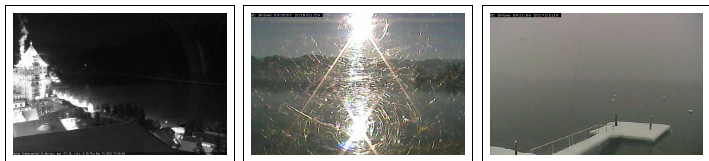
Figure 4. Example images that were discarded from the dataset due to bad illumination ( left ), sun over-exposure ( middle ), and thick fog ( right